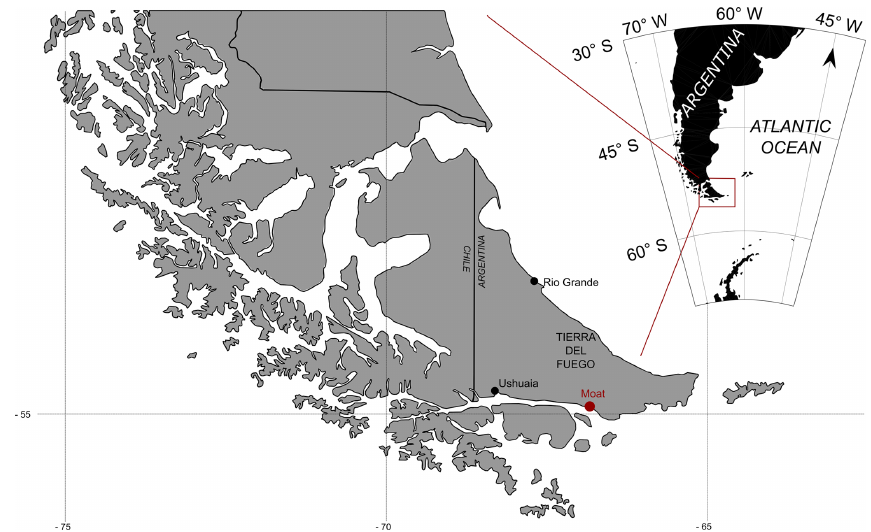
Figure 1. Location of the study area in southernmost Patagonia. The investigated cushion bog in Moat is located 130km east of Ushuaia (Argentina). The map was created at http://www.simplemappr.net (last access: 11 December 2017) and in MATLAB (MATLAB Mapping Toolbox Release